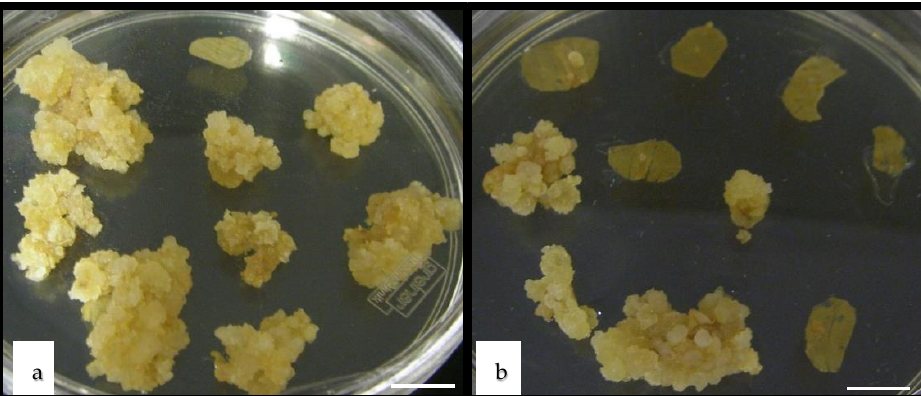
b a Figure 1. Callus production from Medicago truncatula leaf explants. Callus production from Medicago truncatula leaf explants transformed with pCambia1301- WUS-BAR leaves ( a ) and from leaf explants transformed with pCambia- BAR (control, b ), cultured on SH1 medium (4 mg.L − 1 2,4-D, 0.5 mg.L − 1 BAP) during 3 weeks. Scale bar represent 1.0 cm.